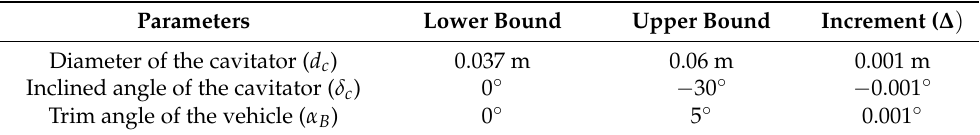
Table 3. Upper and lower bounds and increments of each parameter for the iteration.